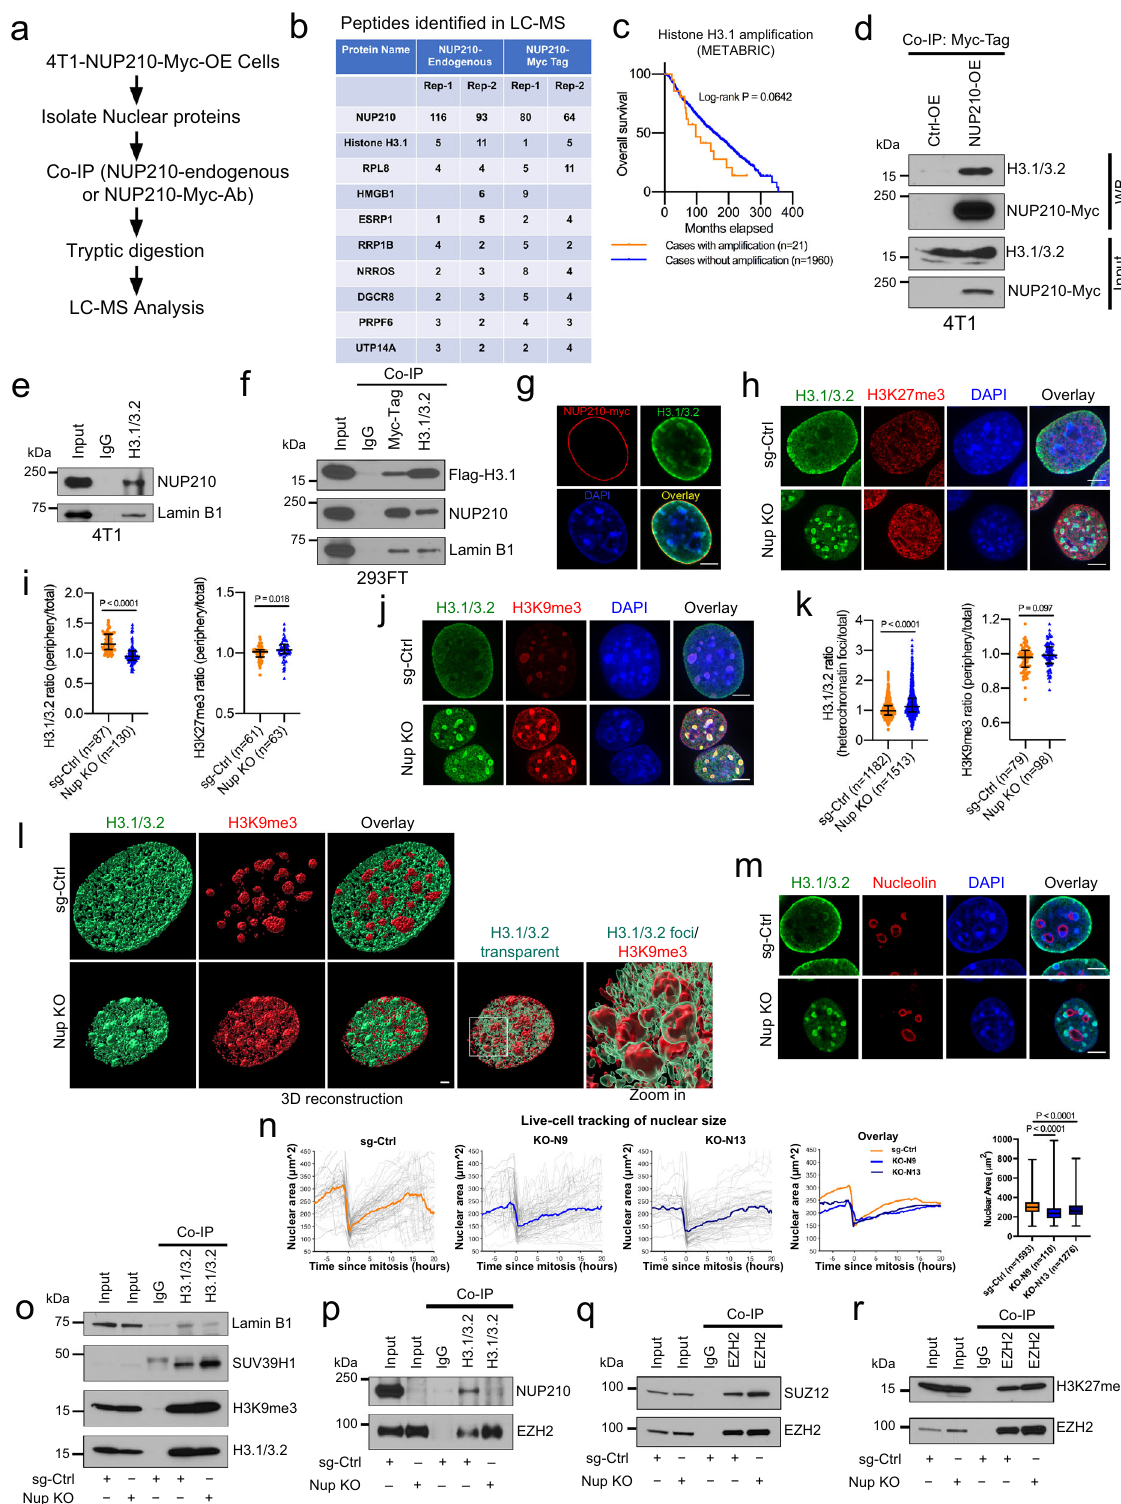
Nup210 loss is associated with differential repositioning of cell spots were observed near the nuclear periphery in aneuploid migration-related gene loci . To determine whether NUP210 4T1 cells (Supplementary Fig. 7a). Interestingly, in Nup210 KO regulates its target genes through anchoring TADs to the nuclear cells, Cxcl , Postn , and Itgb2 loci were repositioned within the periphery, 3D-DNA fl uorescent in situ hybridization (FISH) was nucleus (Supplementary Fig. 7b), with Cxcl and Itgb2 loci repo- performed. FISH probes were generated from bacterial arti fi cial sitioned closer to the nuclear periphery, and the Postn locus chromosome clones (~2 Mb) spanning Cxcl , Postn , Ccl2 , and repositioned away from the periphery. Radial positioning of the Itgb2 genomic regions. As expected, the majority of the FISH Ccl2 locus, however, was not signi fi cantly changed. Rather, the NATURE COMMUNICATIONS| (2021) 12:7216